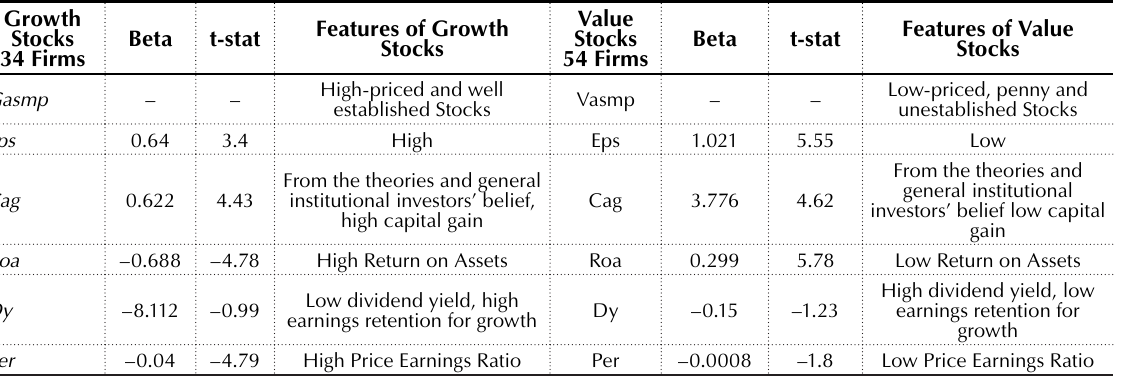
Table 9. Summary of features and xtabond2 coefficients of the Growth and Value Stocks Source: Compiled by the researcher with Microsoft Excel